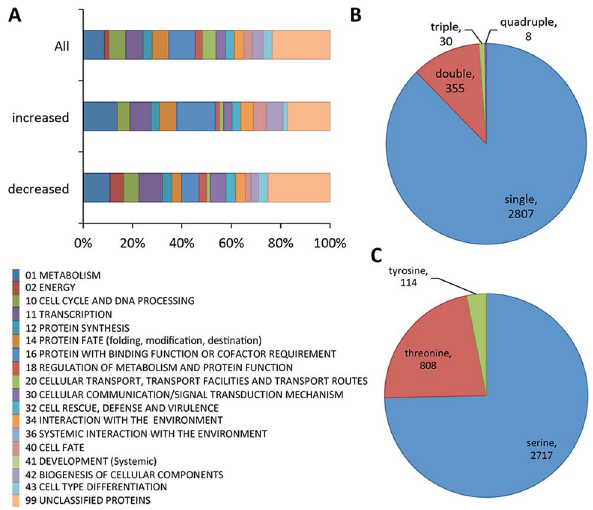
Figure 1. Summary of phosphoproteomics results conducted on D mak-2 Q100G mutant. (A) Overview of FunCat categories of proteins harboring the identified phosphopeptides. The upper bar shows the categories of all the proteins with identified phosphopep- tides (3200 phosphopeptides, 1164 proteins), the middle bar shows functional categories of proteins with phosphopeptides that showed higher abundance after inhibition (33 phosphopeptides, 27 proteins) and the lower bar shows FunCat analysis of the proteins with phosphopeptides that showed lower abundance in mak-2 Q100G germl- ings after treatment with 1NM-PP1 (96 phosphopeptides, 67 proteins). (B) Pie chart showing the relative percentages and absolute numbers of single, double, triple and quadruple phosphosites per peptide. (C) Pie chart showing the relative percentages and absolute numbers of phosphorylated serine, threonine and tyrosine in all peptides found.